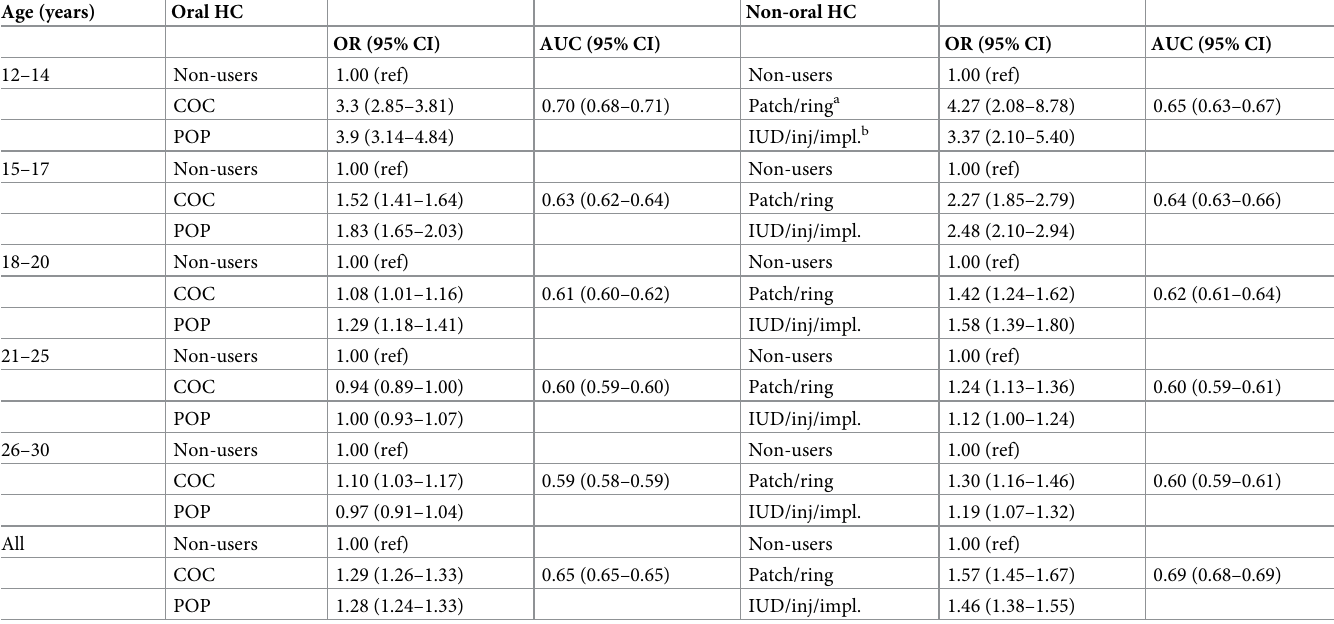
Table 2. Association between different oral and non-oral hormonal contraceptive methods and use of psychotropic drugs within one-year follow-up. Adjusted age- stratified odds ratios (OR) with 95% confidence intervals (CI) for the association between oral and non-oral hormonal contraception (HC) methods and use of psychotro- pic drugs within one-year follow-up after baseline (2010–2011) in 815 662 Swedish women. Non-users used as reference within each age group. The analyses distinguish between combined and progesterone-only methods within the oral and non-oral forms of contraceptives. Adjustments were made for age, family income, highest educa- tional level in family, previous hospitalizations, outpatient hospital visits, and having a diagnosis of thromboembolism, epilepsy or migraine, or menstrual disturbances including